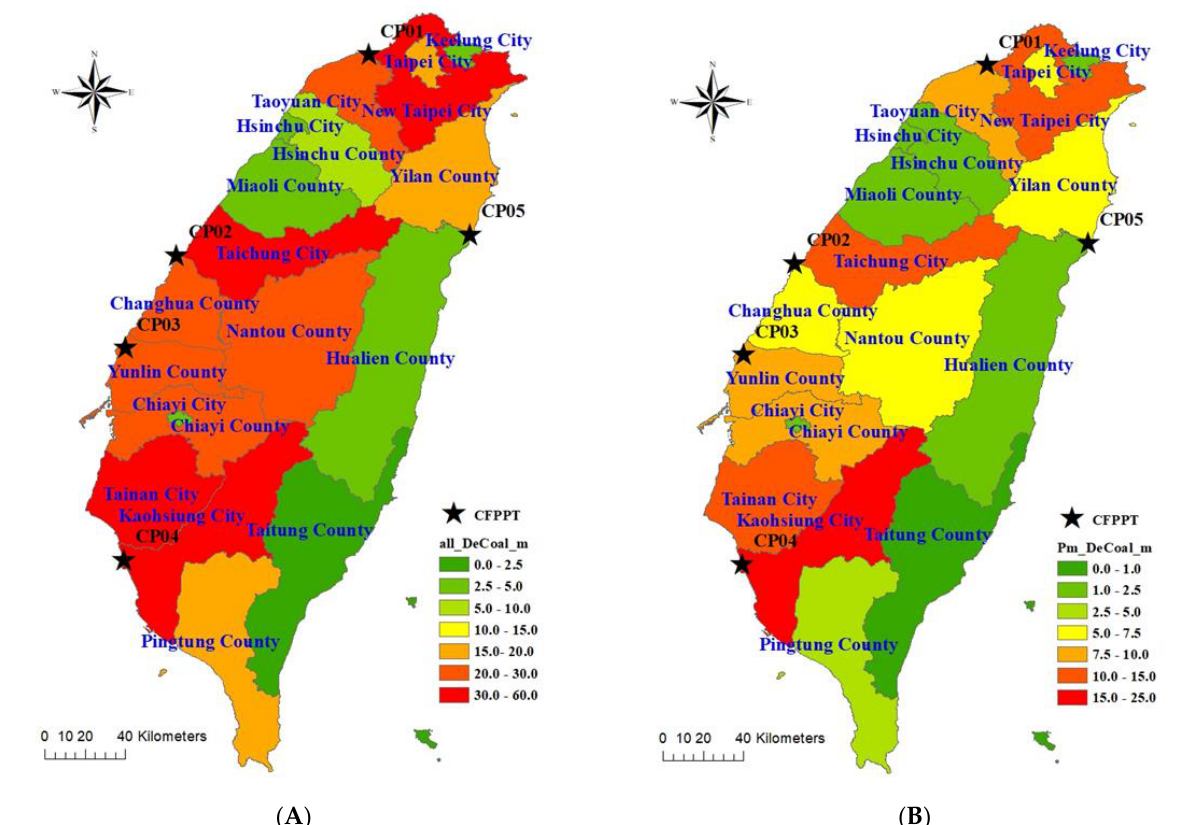
Figure 4. Spatial distribution of city/county based attributable ( A ) total deaths and ( B ) premature deaths due to PM 2.5 from all coal-fired power plants.